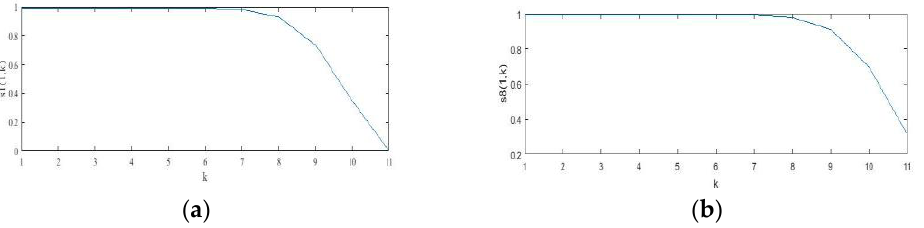
Machines 2017 , 5 , 17 Figure 4. The image of ( a ) S 1 (1, k ); ( b ) S 8 (1, k ) with different k- values.